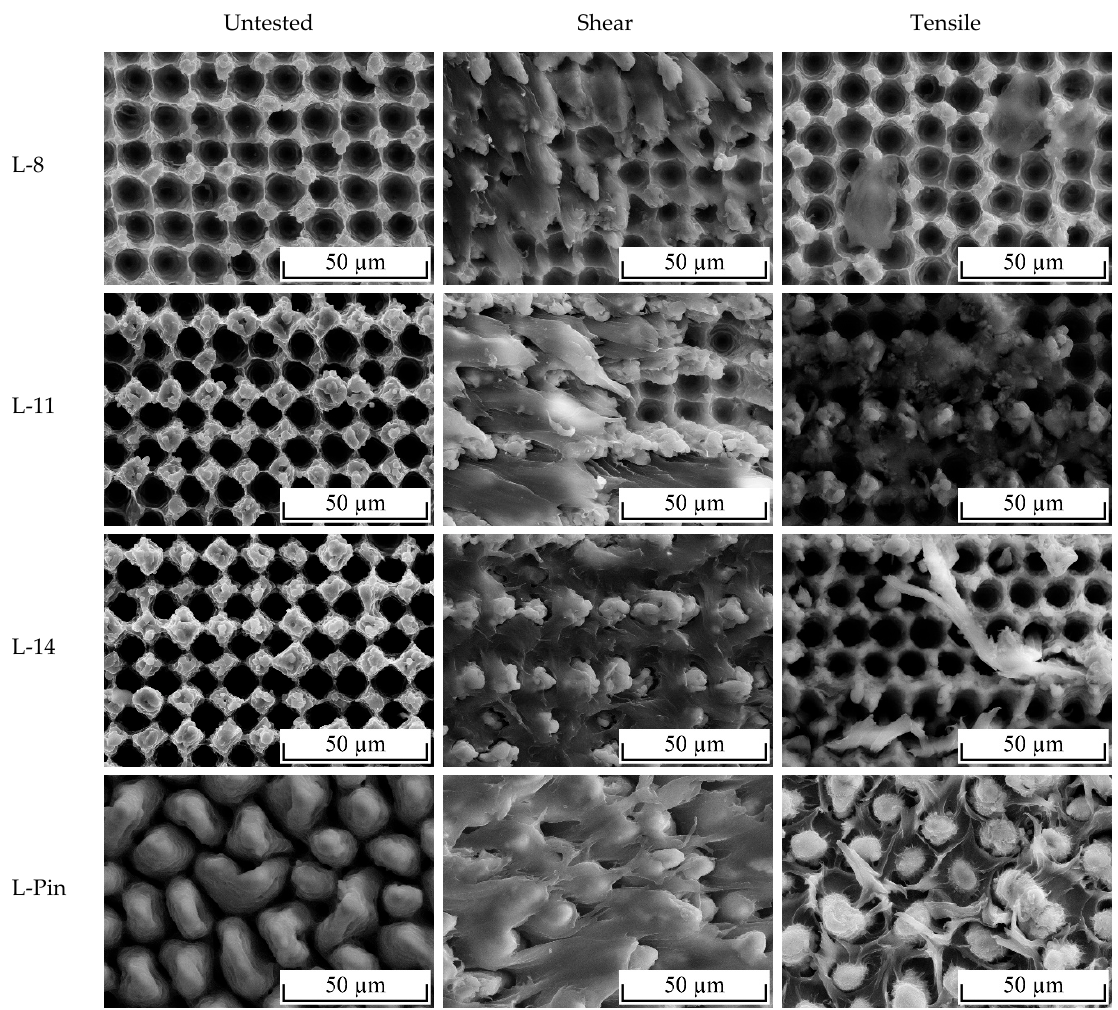
Figure 12. SE images of fractured, laser-structured metal surfaces.